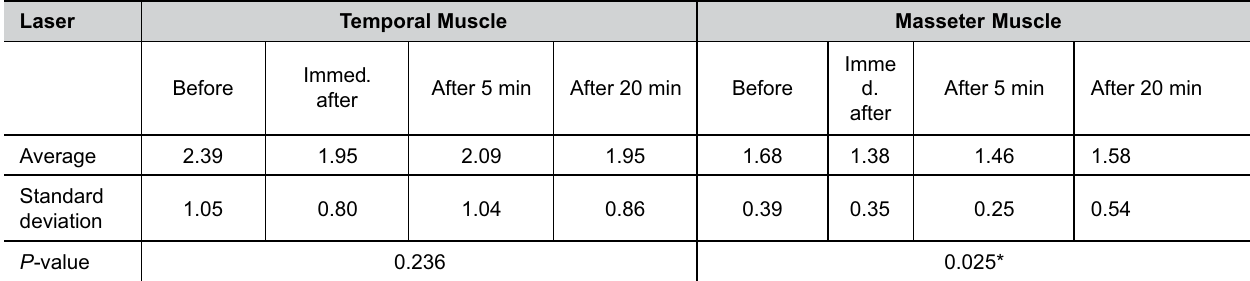
Table 1 – Average of electrical (ìV/ms) activity of the masseter and temporal muscles subjected to laser therapy, measured before, immediately after, 5 minutes and 20 min after LLLT.